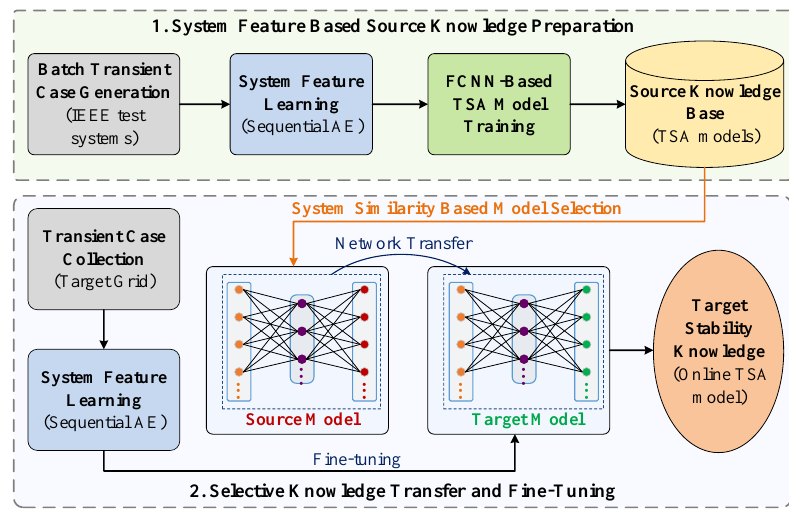
Figure 2. Framework of the proposed